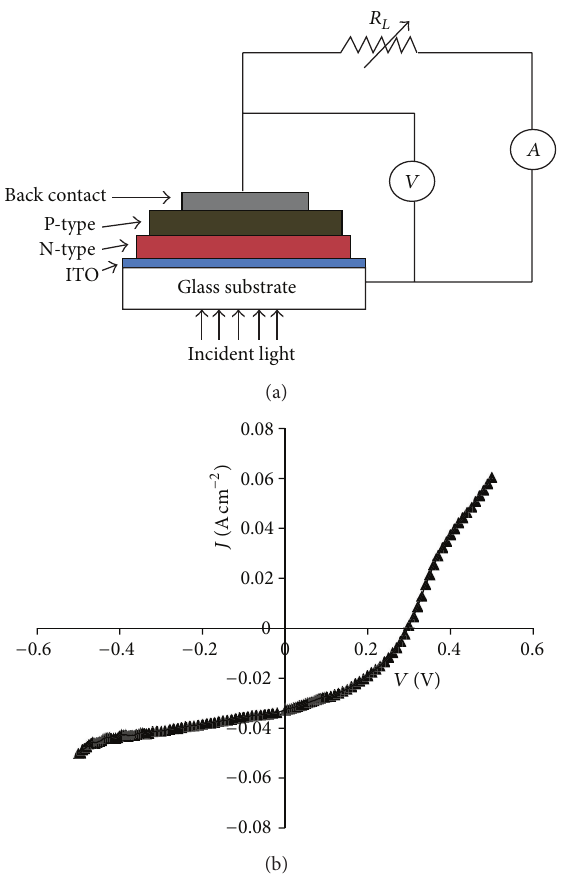
Figure 4: (a) Experimental setup for measuring the current- voltage characteristics of CdSe/CdTe thin film solar cell and (b) I - V characteristics of CdSe/CdTe thin film solar cell. Table2:GrainsizeandstructuralparametersofCdSethinfilmfrom XRD.